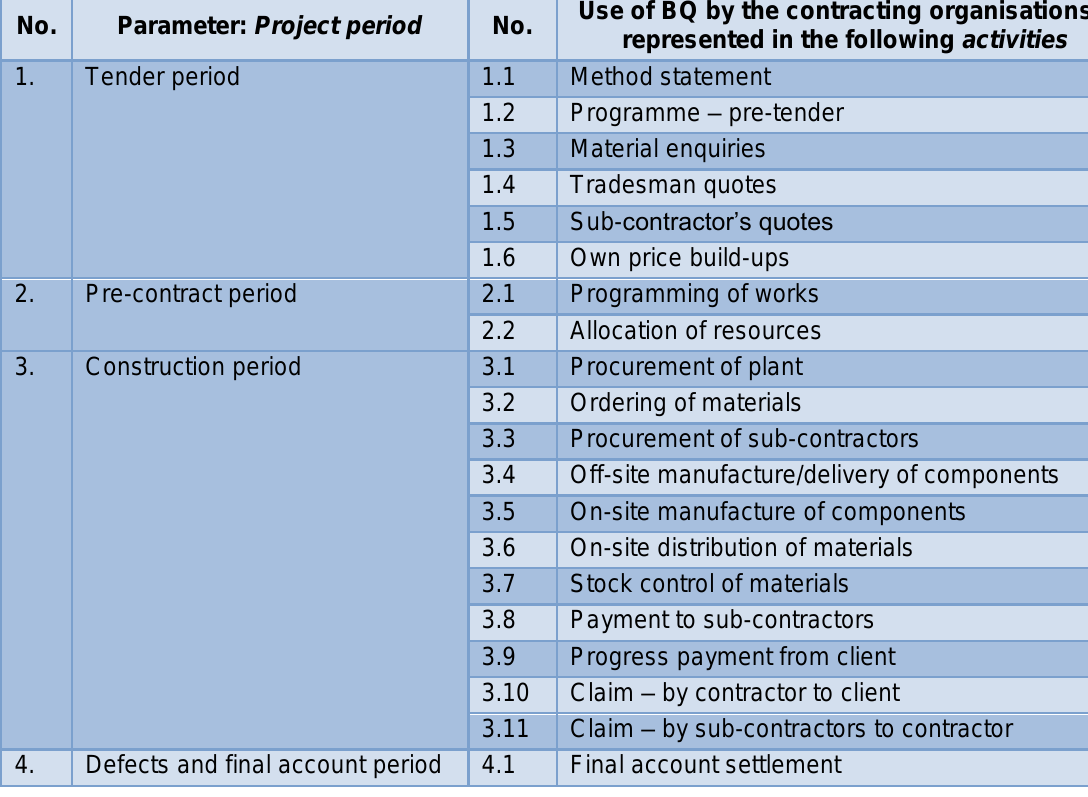
Table 4 The use of the BQ by the contracting organisations by Smith and Hoong Source: adapted from Smith and Hoong (1985, p.